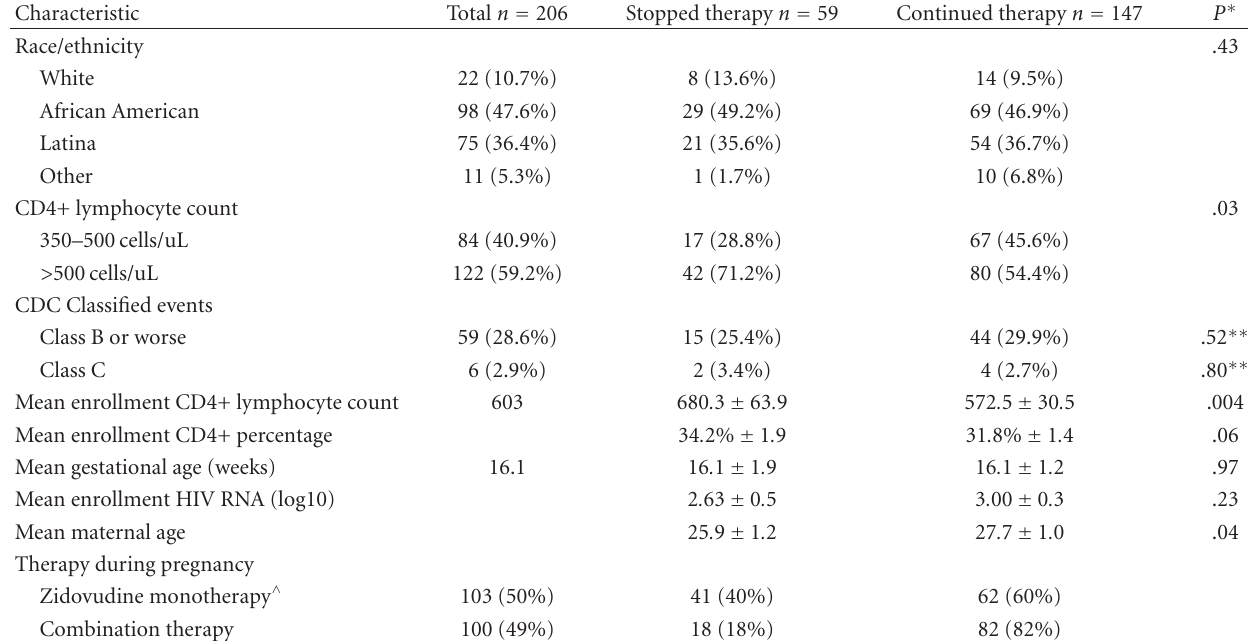
Table 1: Baseline characteristics of women included in the study according to status of antiretroviral therapy after delivery.